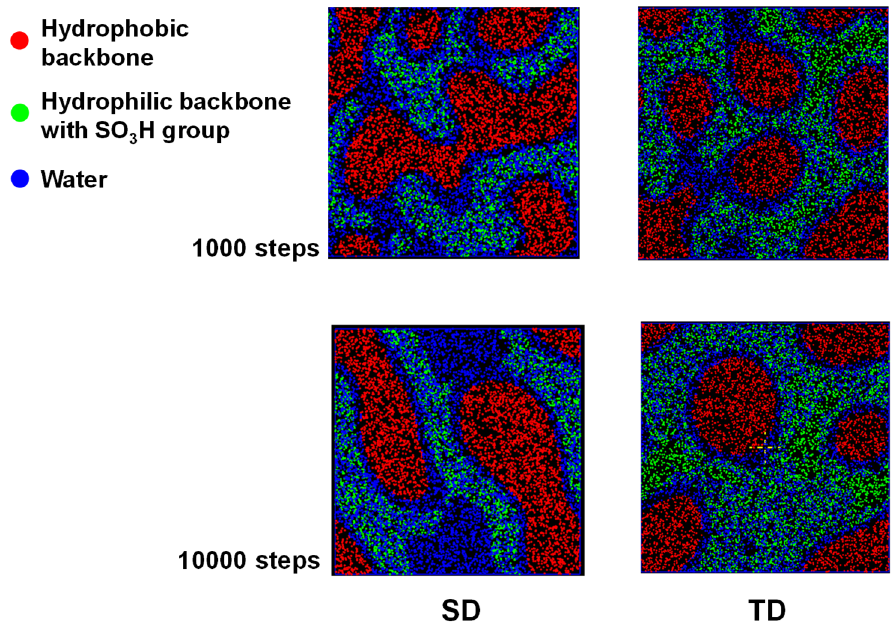
Figure 2. Sliced images of 3D mesoscale results at 298 K after 1000 and 10,000 steps.